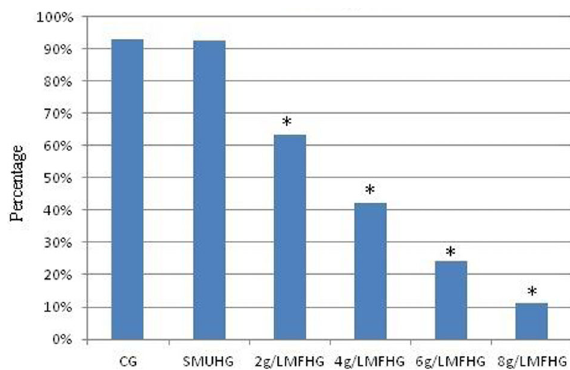
Figure 9. p53 histogram of SMMC-7721 cells after treatment. CG: control group A; SMUHG: spiking group (8 g/L Fe 2 O 3 , no radiation); MFHG: MFH group; PI: positive index. *P , 0.05 compared with CG ( t -test).